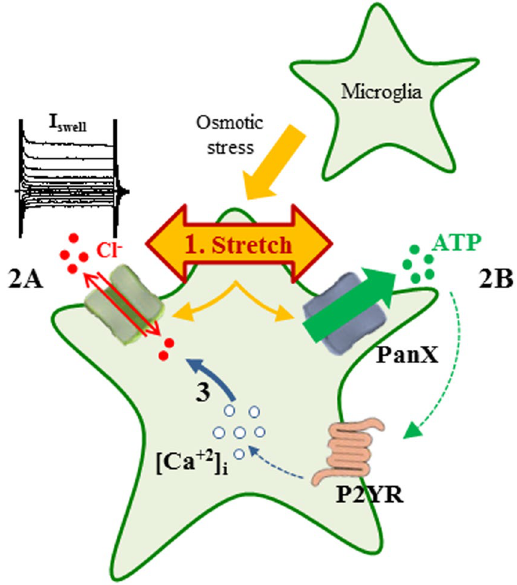
Figure 8. Model of the Ca 2 + and ATP-dependent activation loop for hypotonic-induced currents in microglial cells. Osmotic stress causes cell swelling and a consequent membrane stretch (1), inducing a swell-dependent chloride current ( 2A ) and ATP release through pannexin hemichannels ( 2B ). ATP amplifies the current activation by binding to P2Y purinergic receptors ( P2YR ), possibly through Ca 2 + -dependent mechanisms. I Swell : swell-activated anionic channels; PanX pannexin1